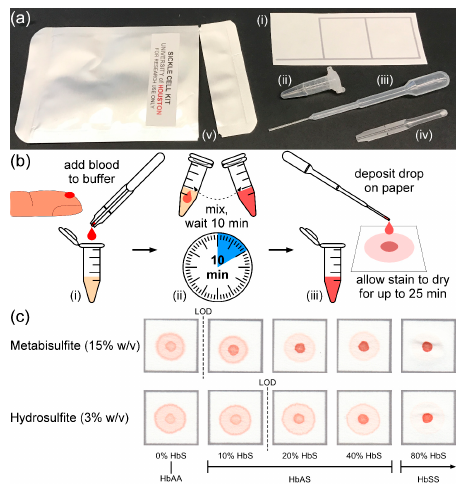
Figure 1. Overview of the distributable paper-based SCA diagnostic test kit. ( a ) Photograph of the sickle cell kit with all components necessary to perform the test: (i) patterned chromatography paper; (ii) reagent tube containing reagents; (iii) reagent dropper; (iv) blood dropper; and (v) foil pouch. ( b ) Schematic illustration showing the steps required to perform the paper-based test: (i) ~20 µL of whole blood is collected via finger-stick using the blood dropper and deposited in the reagent tube; (ii) the blood is mixed with a preset volume of buffer (containing either sodium hydrosulfite or sodium metabisulfite) via manual agitation; and (iii) after 10 min, a drop (~20 µL) of the mixture is deposited on the chromatography paper using the reagent dropper and allowed to dry for up to 25 min before being evaluated visually. ( c ) Representative bloodstains produced by the metabisulfite (top) and hydrosulfite (bottom) versions of the paper-based test for samples with various sickle hemoglobin (HbS) concentrations. The limit of detection (LOD) for each version is indicated by a dashed line. Typical HbS concentration ranges for adults and children older than six months of age with different genotypes (normal— HbAA ; SCT— HbAS ; SCA— HbSS ) are marked below the stains.